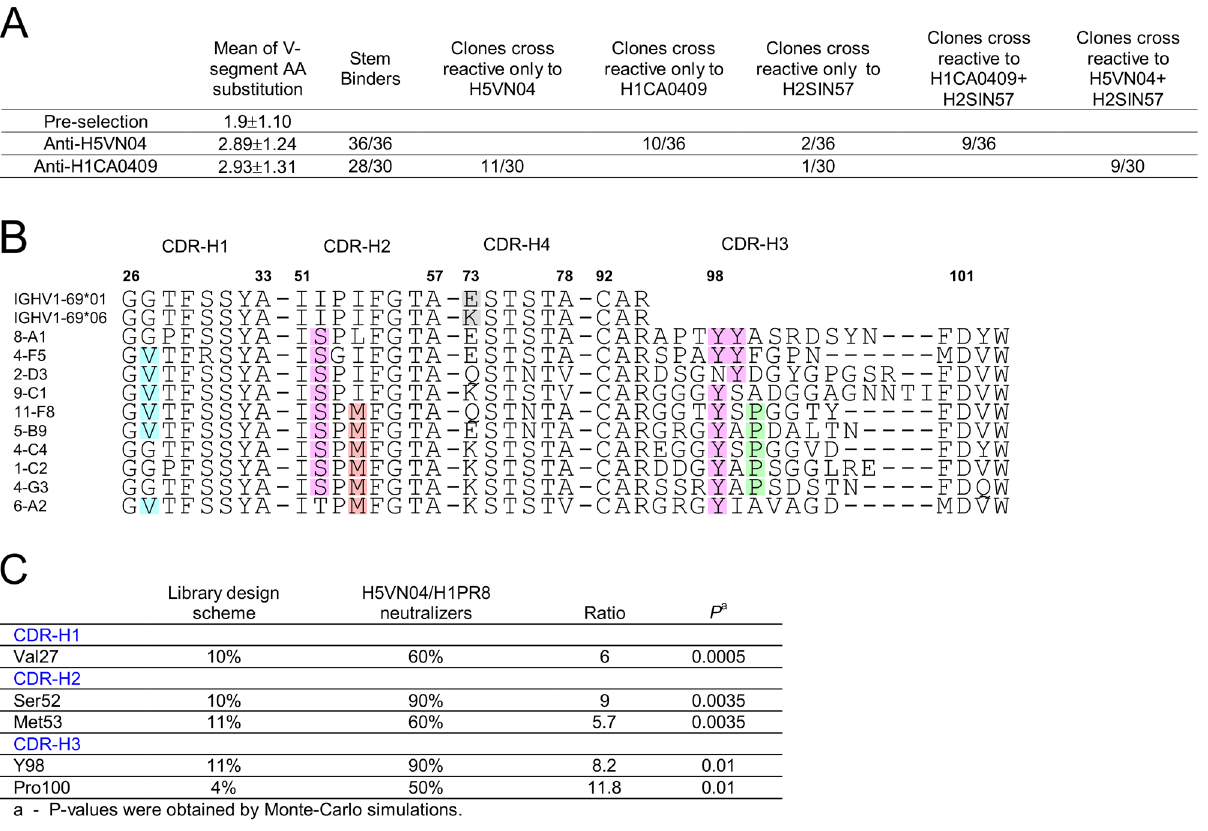
Figure 4. Semi-synthetic HV1-69 phage-Ab library yields potent anti-H5VN04/H1CA0409 Abs characterized by a minimal V- segment amino acid substitutions. A ) Characterization of binding activities of anti-H5VN04 and anti-H1CA0409 phage-Abs isolated from the semi-synthetic HV1-69 phage-display library. Sequences are detailed in Figure S4 in Text S1 . B ) Heavy chain CDR sequences of anti-H5VN04 phage Abs characterized by . 95% neutralization activity against both H5VN04 and H1PR8 pseudotyped viruses. The 5 highlighted residues in the CDRs refer to panel C ) which describes the result of a Chi square statistical analysis approach used to identify residues that were significantly enriched as compared to their frequency in the library (P , 0.05). Also highlighted are Tyr99 and position73 in the IGHV1-69 germline sequences.